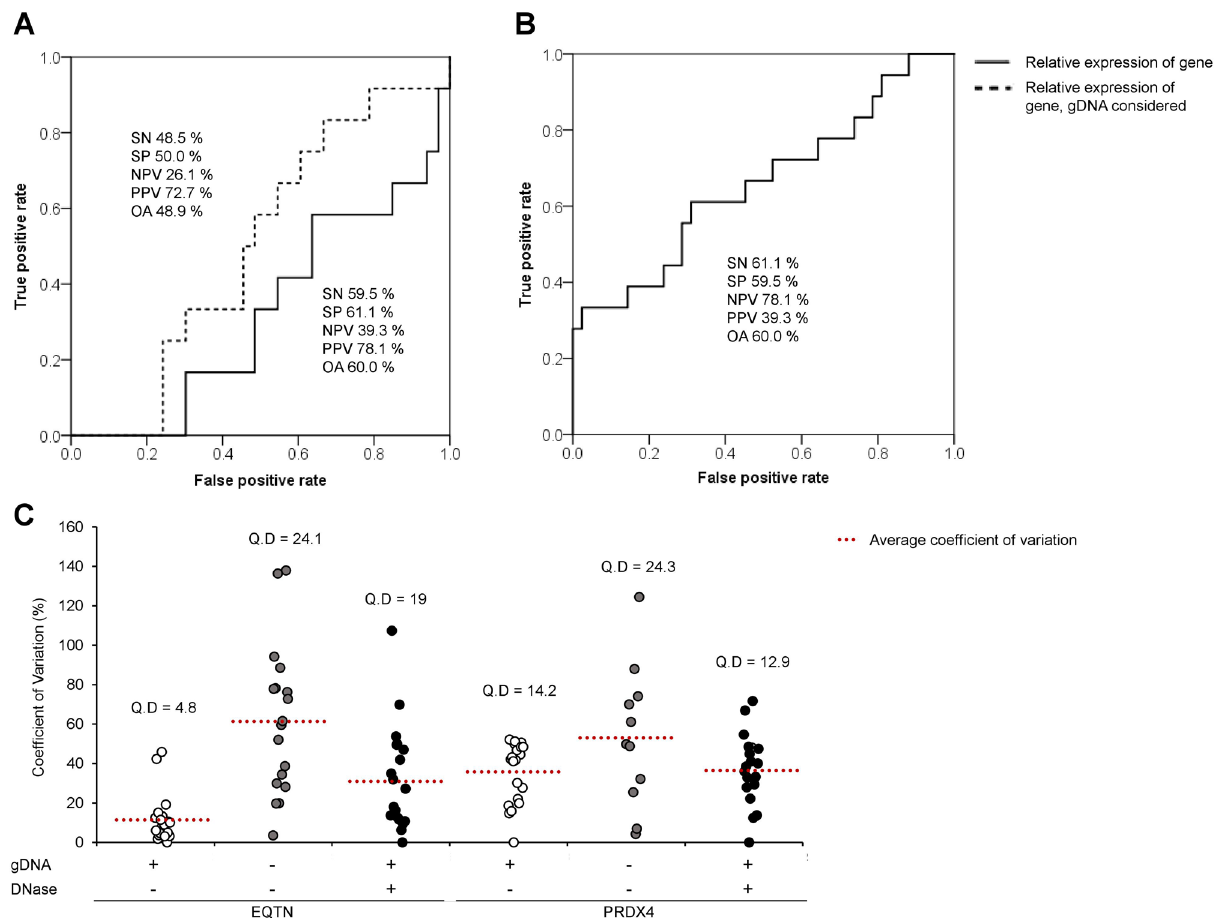
Figure 4. ROC curve of EQTN and PRDX4 expression comparing litter size. ( A ) ROC curve for EQTN mRNA expression when gDNA was considered or not and litter size in isolated RNA without DNase in 20 randomly selected boar spermatozoa. ( B ) ROC curve for PRDX4 mRNA expression and litter size in isolated RNA without DNase in 20 randomly selected boar spermatozoa. ( C ) The coefficient of variation (%) and quartile deviation (Q.D) of EQTN and PRDX4 mRNA expression in each processing method. The cut-off values of relative expression in all treatments were determined based on fixed litter size (13) for comparison among each treatment. Sensitivity (SN) is the percentage of boars showing true-positive results when tested with mRNA expression. Specificity (SP) is the percentage of boars showing true-negative results. The positive predictive value (PPV) is the percentage of boars that tested as positive and simultaneously has a true-positive litter size. The negative predictive value (NPV) is the percentage of boars that tested as negative or simultaneously had a true-negative litter size. OA, Overall